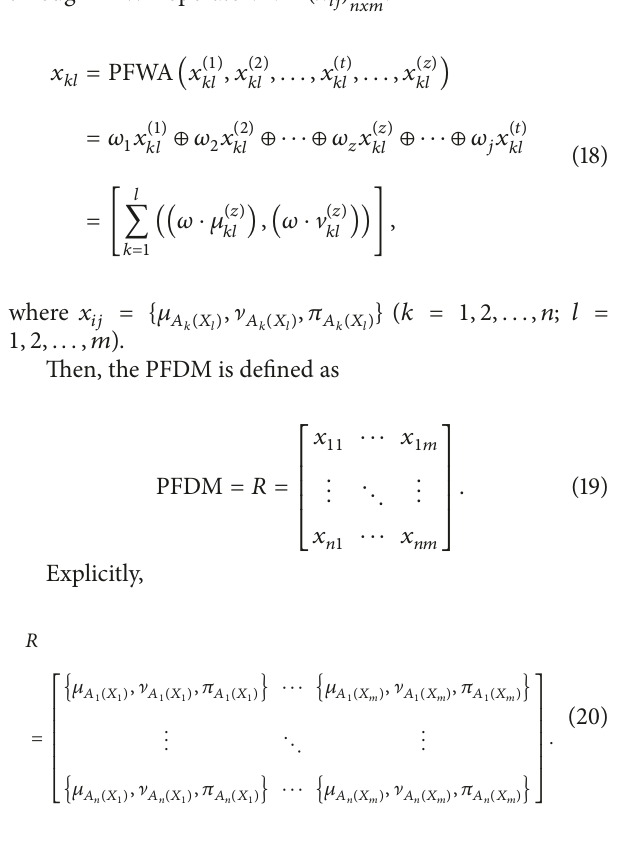
All preferences of the DMs need to be involved into a gathered Pythagorean fuzzy decision matrix (PFDM) through PFWA operator: 𝑅 = (𝑥 𝑖𝑗 ) {0.10, 0.99} 𝑛𝑥𝑚